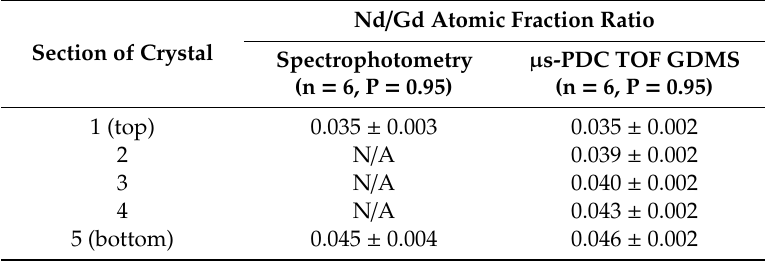
Table 1. Atomic fraction ratios of Nd / Gd along the crystallographic growth axis from the crystal’s top (seeding side—1) to its bottom (opposite